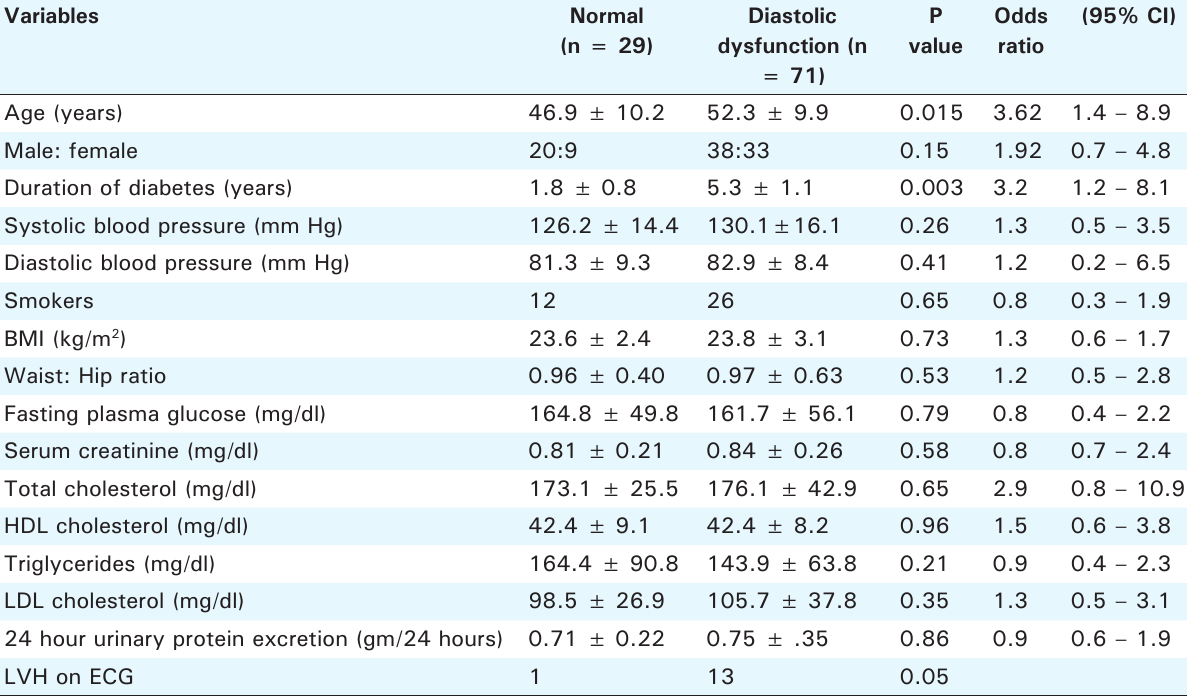
table 1. comparison of characteristics between subjects with normal and those with diastolic dysfunction.